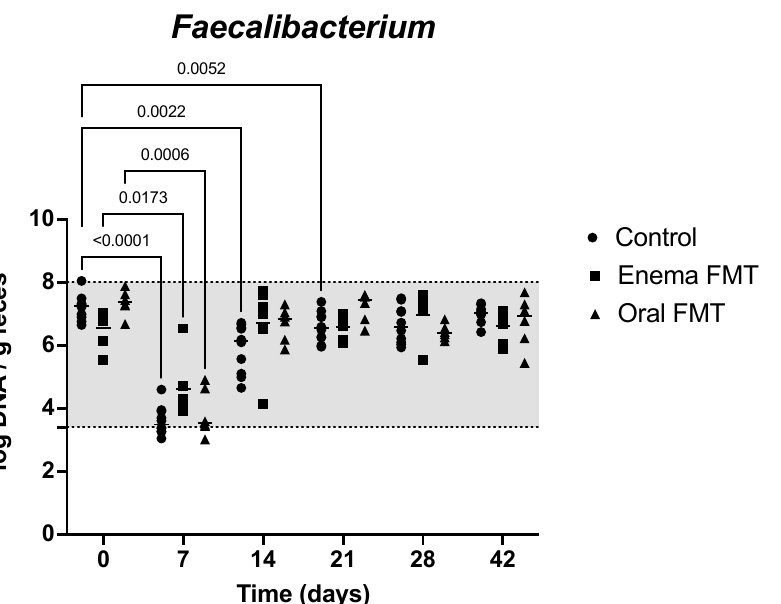
Figure 4. Dot plot graph representing the variation of fecal Faecalibacterium abundance in control dogs, dogs receiving FMT by enema, and dogs receiving FMT orally over the 6-week duration of the study. Legend: The shaded area highlights the reference interval of the abundance for Faecalibacterium in dog feces. Dots represent individual values for each dog, bars denote median for the group and time point. Statistically significant pairwise comparisons with baseline in each group are shown. 3.3. Fecal Bile Acid Concentrations Data on fecal bile acid concentrations for the first 14 days of the study are summa- rized in Table 2. Total primary and percentual fecal UBA concentrations were markedly increased on D7 in all groups when compared to baseline. They normalized in all dogs one week later. Conversely, total and percentual secondary fecal UBA concentrations were severely decreased on the last day of tylosin treatment (D7) in all groups when com- pared to baseline. However, they returned to baseline at D14 and were not different from baseline in any of the following sampling points in any group (Figure 5). The two control dogs with continuously decreased C. hiranonis concentrations at D14 and D21 also main- tained a high percentage of primary bile acids (D14: 83.7 and 88.9, resp; D21: 64.7 and 52.8, resp.) and a low percentage of secondary bile acids (D14: 16.3 and 11.1, resp.; D21: 35.3 and 47.2, resp.) at these time points.